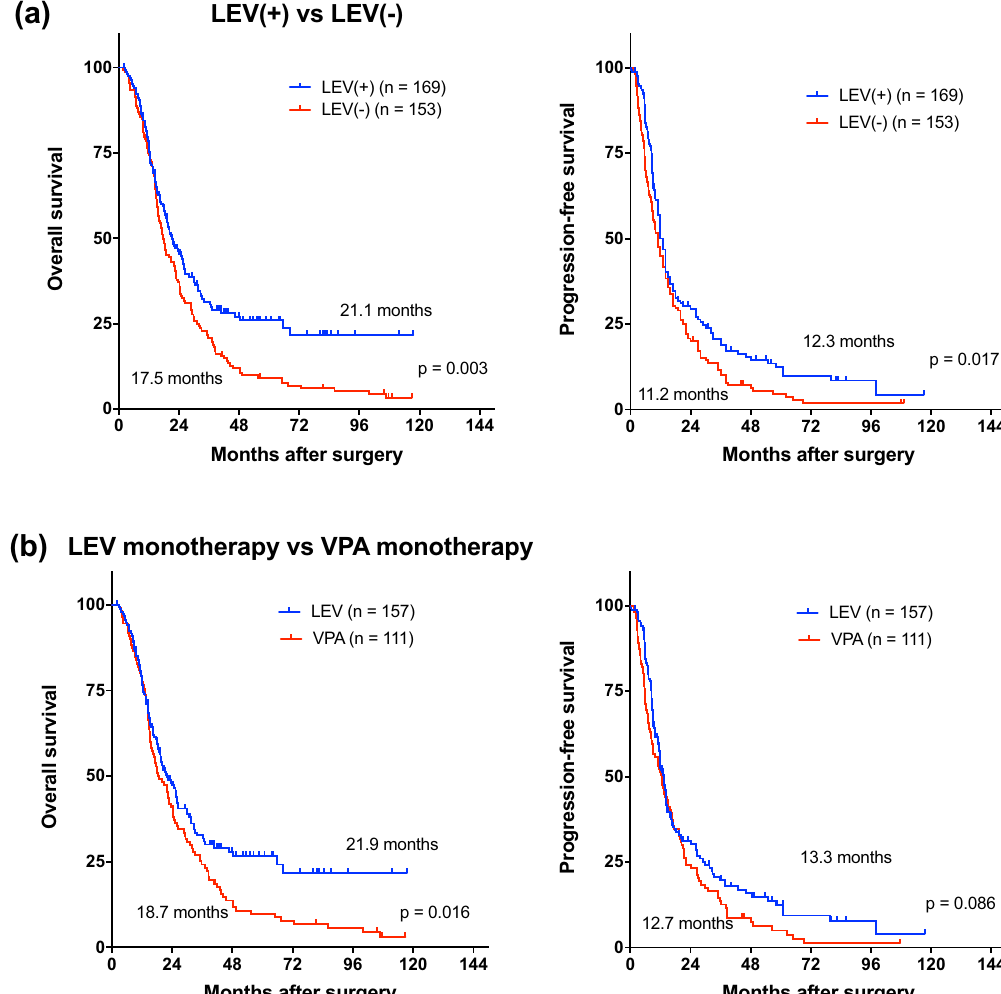
Figure 1. ( a ) Kaplan–Meier survival curves showing the overall survival and progression-free survival of patients. The overall survival was 21.1 months in the LEV (+) group and 17.5 months in the LEV (−) group (P = 0.003). The progression-free survival was 12.3 months in the LEV (+) group versus 11.2 months in the LEV (−) group (P = 0.017). ( b ) Comparison of the LEV monotherapy group and VPA monotherapy group. The overall survival was 21.9 months in LEV monotherapy group and 18.7 months in VPA monotherapy group (P = 0.016). Progression-free survival was 13.3 months in the LEV group and 12.7 months in the VPA group (P =